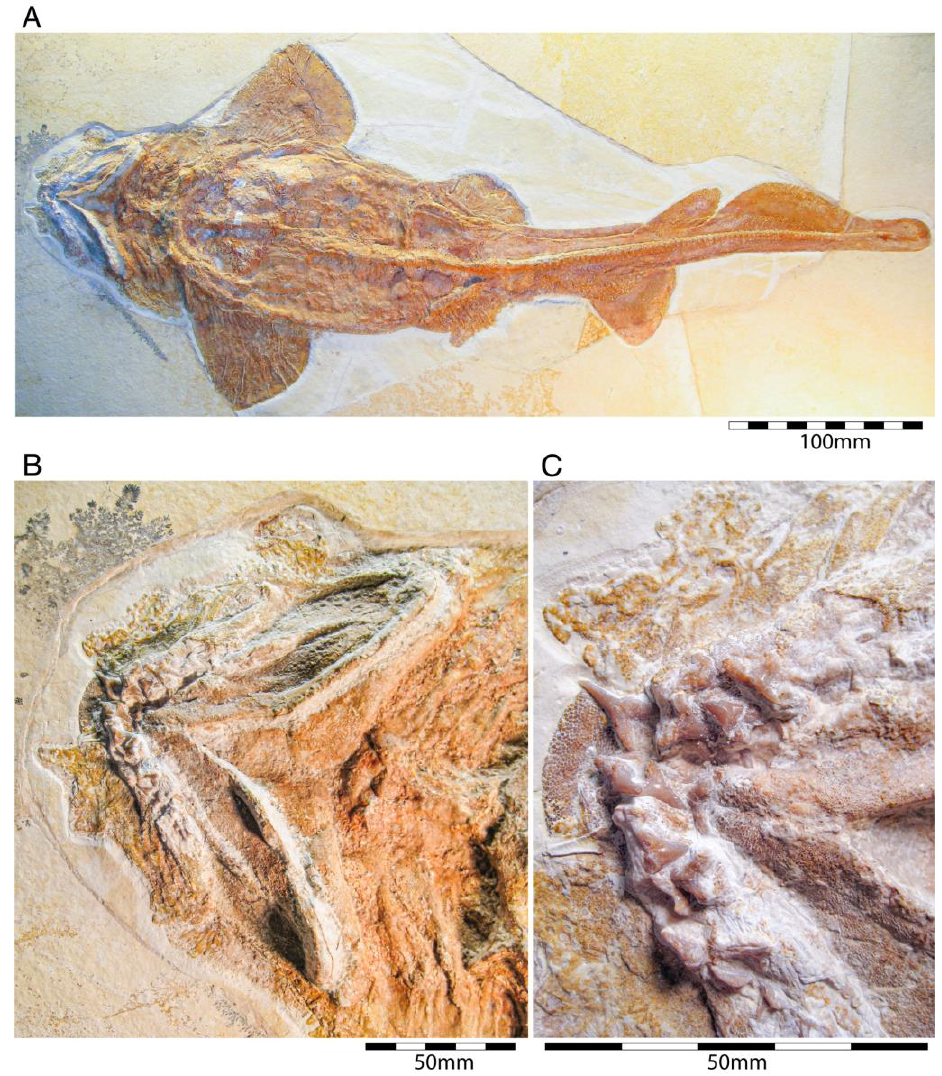
Figure 26. † Palaeocarcharias stromeri de Beaumont, 1960 [51], ( A ) Holotype specimen (JME SOS 2294) from the lower Tithonian of Eichstätt. ( B ) Close up of the cephalic regions. ( C ) Close up of the anterior portion of the